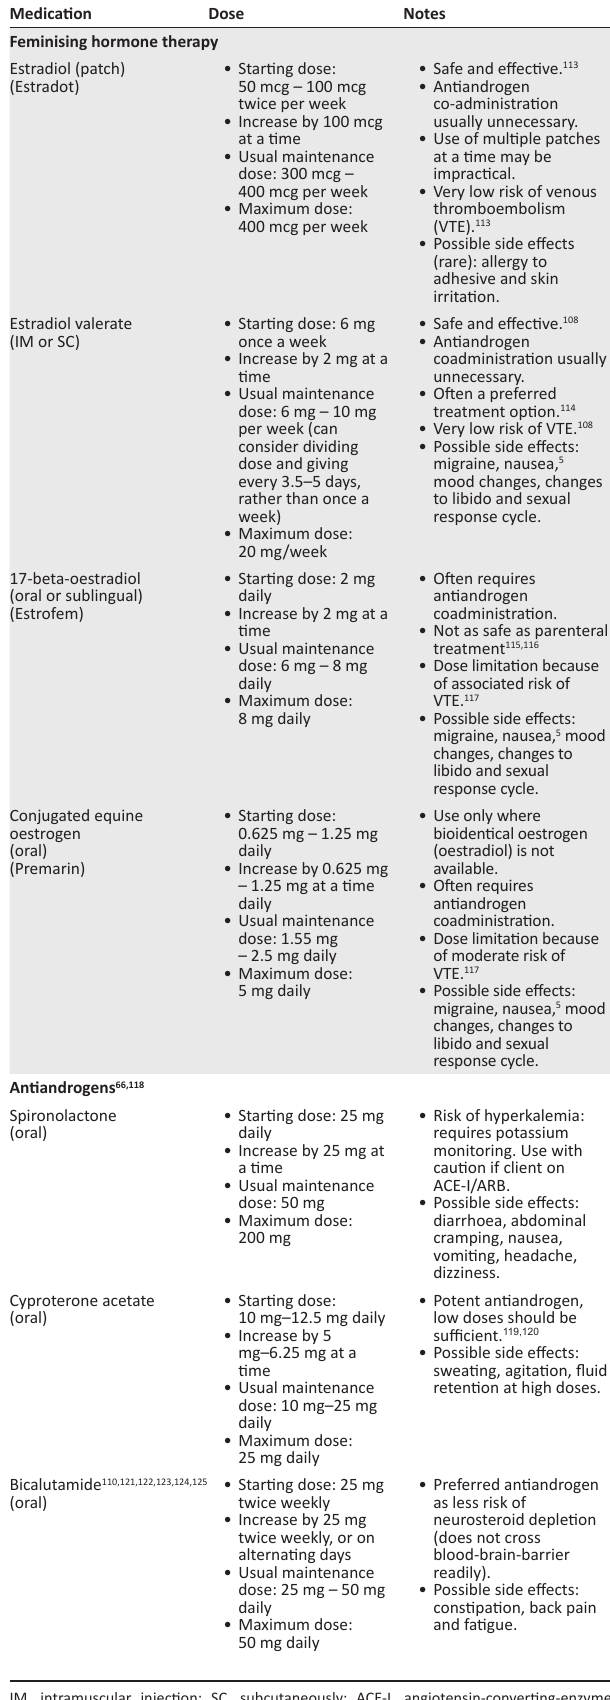
TABLE 4: Feminising hormone therapy and